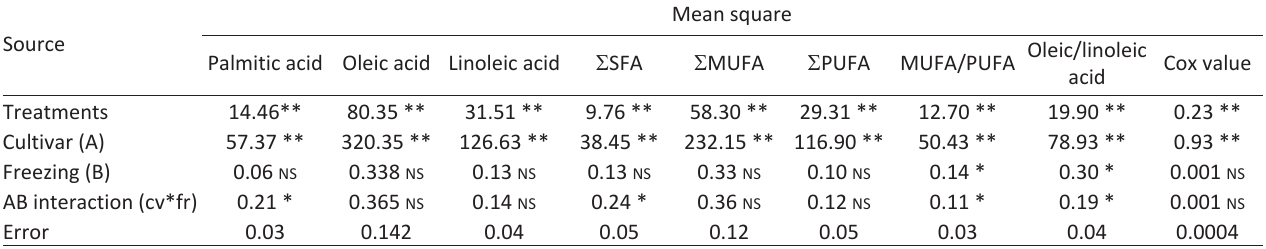
Table 6 - Results of ANOVA for fatty acids (reported in table 5) composition of olive oils derived from fresh and frozen olive fruits